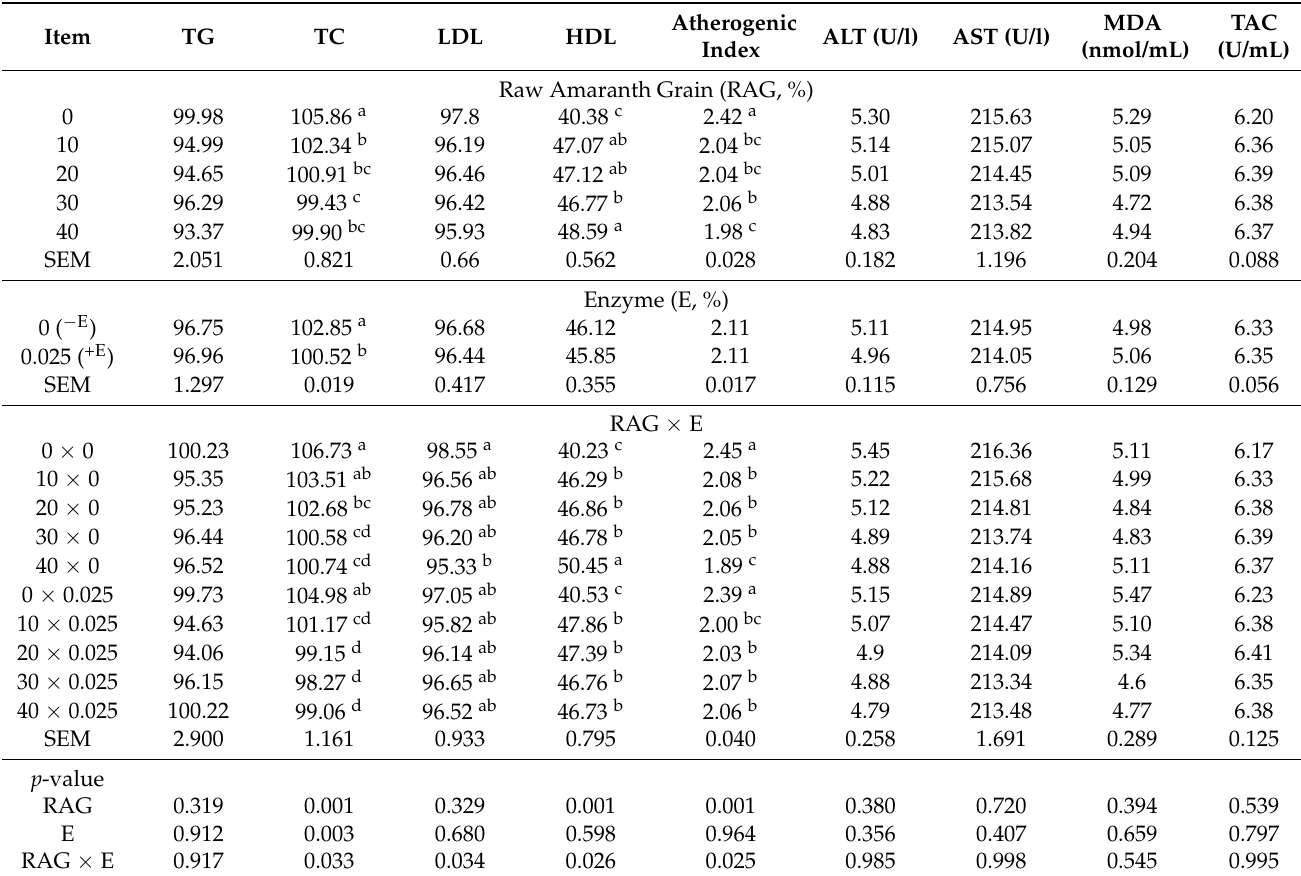
Table 6. Effect of experimental diets on blood biochemistry and antioxidant status parameters of laying